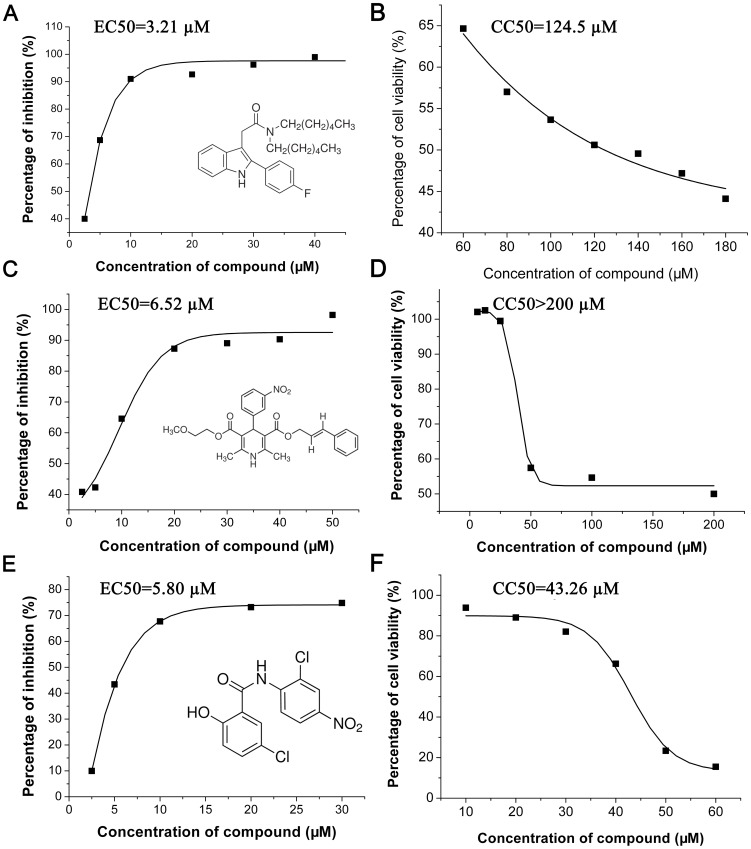
Dose-dependent response of the compounds on JEV replication and cell proliferation.A, C and E show inhibitory effects of different concentrations of FGIN-1-27, cilnidipine and niclosamide, respectively. B, D and F show cell viability in different concentrations of FGIN-1-27, cilnidipine and niclosamide, respectively. EC50s and CC50s were calculated by nonlinear regression. The 2D structures of corresponding compounds are also shown in A, C and E.